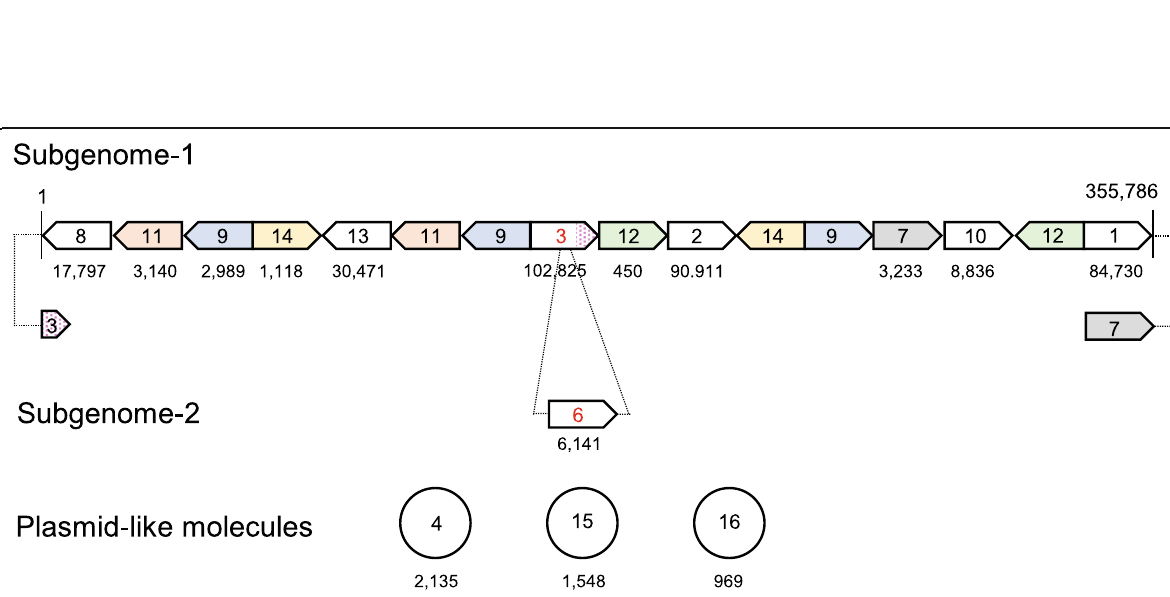
Fig. 1 The pollen, anthers and seed setting of TAA, TAR, and Taichung 65 (T65). a Mature pollen stained with I 2 -KI (Bar = 25 μ m). b Anthers at the flowering stage. (Bar = 1 mm). Arrows indicate dehiscence of anthers. c Seed setting of bagged panicles. Panel C-1 indicates no seed setting without artificial pollination, while panel C-2 indicates seeds on clipped spikelets after compulsive self-pollination of TAA (Bar = 1 cm)